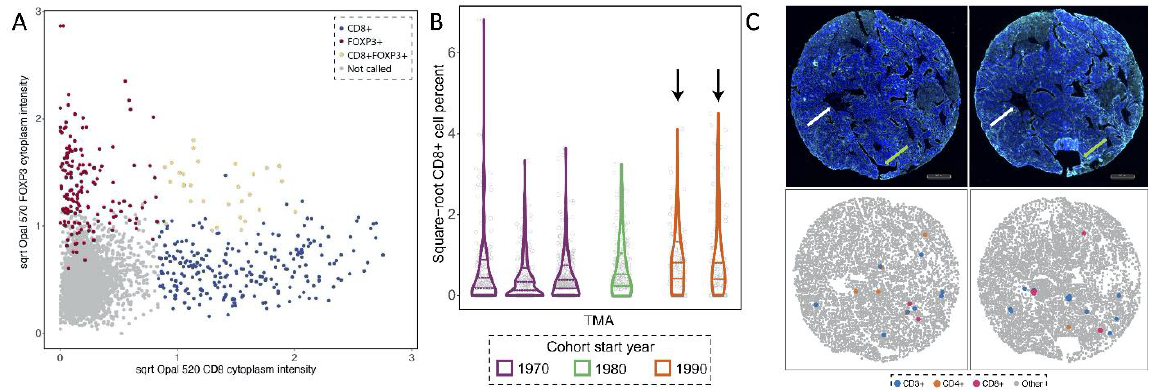
Figure 2. ( A ) Square-root transformed CD8 (Opal 520) and FOXP3 (Opal 570) fluorescence intensities of a tumor microarray core from an epithelial ovarian cancer tumor. Cell classifiers used in immunofluorescence studies can yield equivocal CD8+FOXP3+ assignments. Note that the CD8 threshold creates a clear separation of CD8+ cells, however the FOXP3 intensity threshold allows for a mixture of unassigned and FOXP3+ cells. ( B ) Square-root transformed percent of CD8+ cells detected in 1312 epithelial ovarian cancer tumor slices from 445 participants. The tumor slices come from 6 different TMAs, with initial collection of tissues starting at different times since the 1970s. The three horizontal lines represent the 1st, 2nd, and 3rd quartiles, and the width of the violin plots represent the number of slices showing a given percentage. As showed by narrower violin bases, the TMAs generated starting in the 1990s show less zeroes in CD8+ cell counts compared to the other TMAs generated in previous years. ( C ) mIF images from the same core from an ovarian cancer TMA. The two slices were stained with pan-cytokeratin (PCK) but were applied two different mIF panels to detect B and T cells (top). The cells detected after image processing are shown. Differences are observed between the two slices, including the presence of “holes”, making difficult to perform comparative spatial analysis of the two slices from the same TMA core. The white arrows correspond to a region that is similar across the different sections of the same core, while the green arrows correspond to regions that are dramatically different. Illustration that plots generated from mIF data capture these features and maintain the cell locations (bottom).